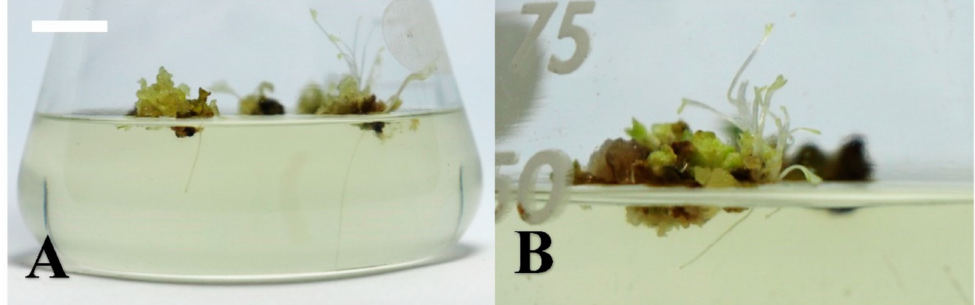
Figure 4. Root induction from wild strawberry ( Fragaria vesca ) shoots under the dark condition after 8 weeks of culturing (bar). ( A ) the indole-3-butyric acid (IBA) 0.41 µ M treatment (10 mm); ( B ) the IBA 4.14 µ M treatment (5